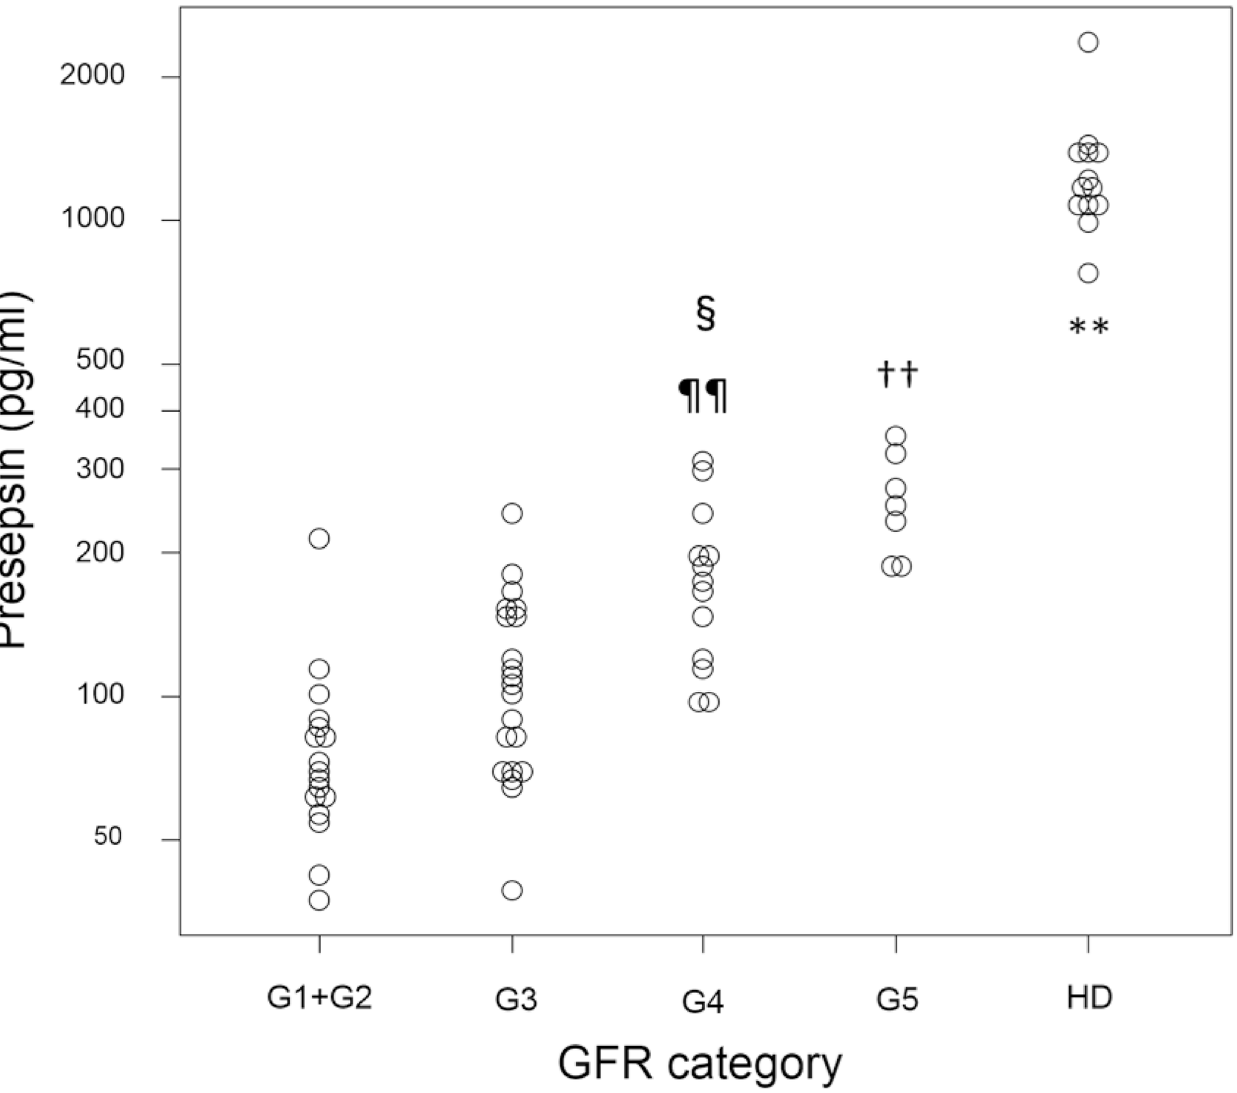
Fig 1. Dot plot of presepsin values of patients in the different GFR categories or of patients receiving HD. G1: GFR (cid:1) 90 ml/min/1.73m 2 , G2: GFR = 60 to 90 ml/min/1.73m 2 , G3: GFR = 30 to 60 ml/min/1.73m 2 , G4: GFR = 15 to 30 ml/min/1.73m 2 , G5: GFR (cid:3) 15 ml/min/1.73m 2 , HD: hemodialysis. ** P < 0.01 compared to any other GFR category. †† P < 0.01 compared to G3 and G2+G1. ¶¶P < 0.01 compared to G1+G2. §P < 0.05 compared to